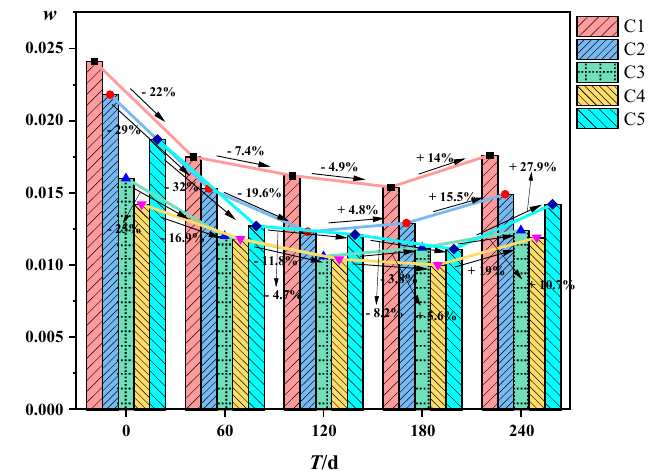
Figure 7. Concrete water absorption rate